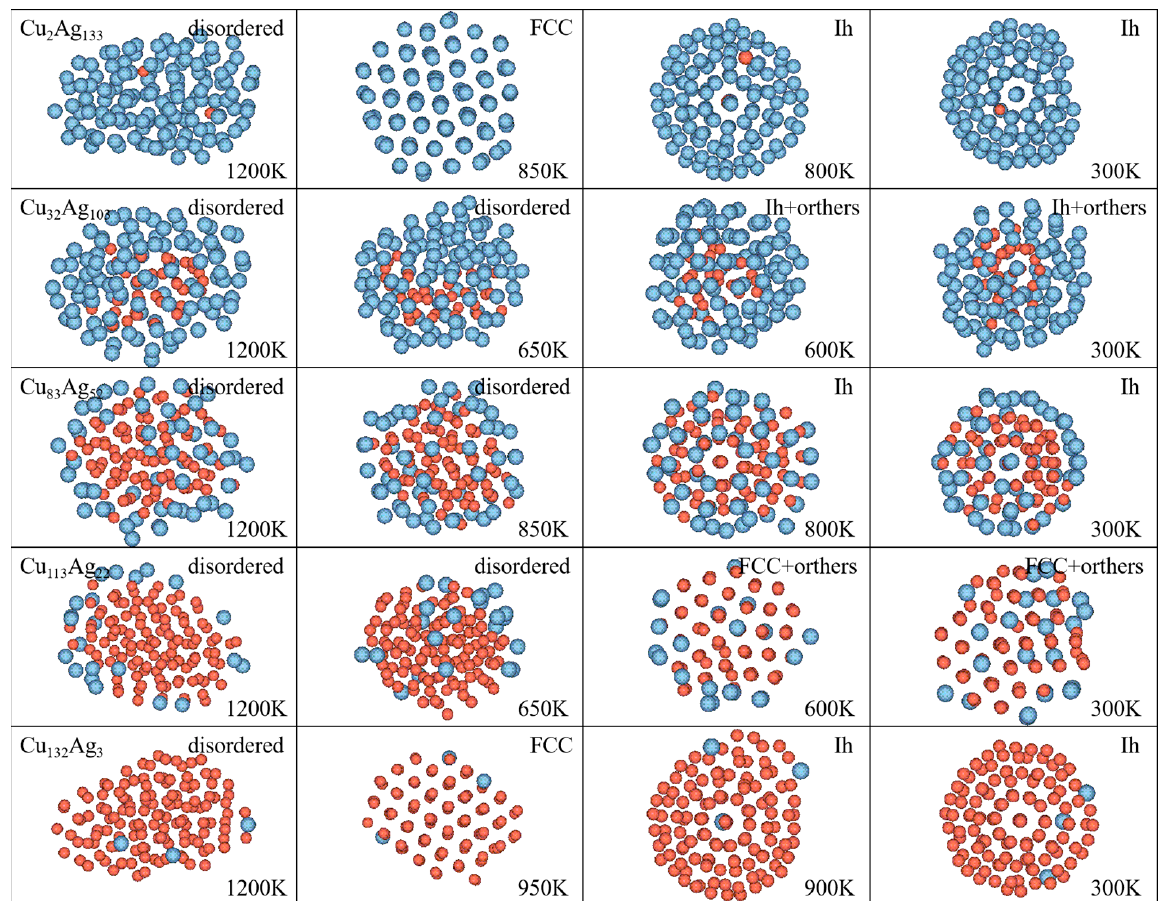
Figure 4. Packing structures of the clusters at different temperatures.